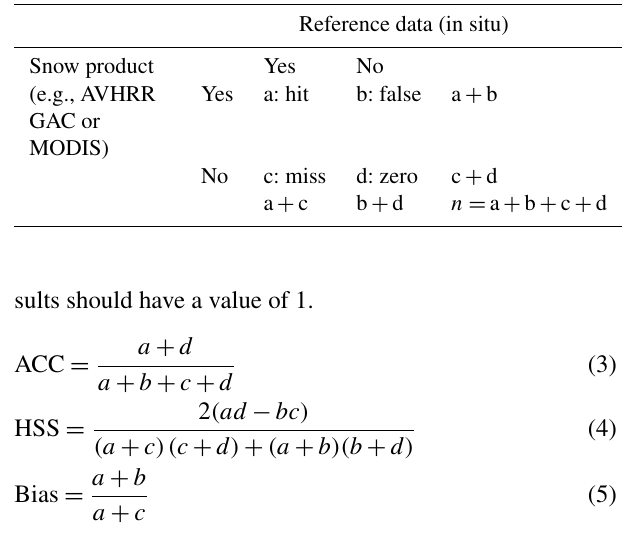
Table 3. Contingency table used to determine probability of detec- tion and